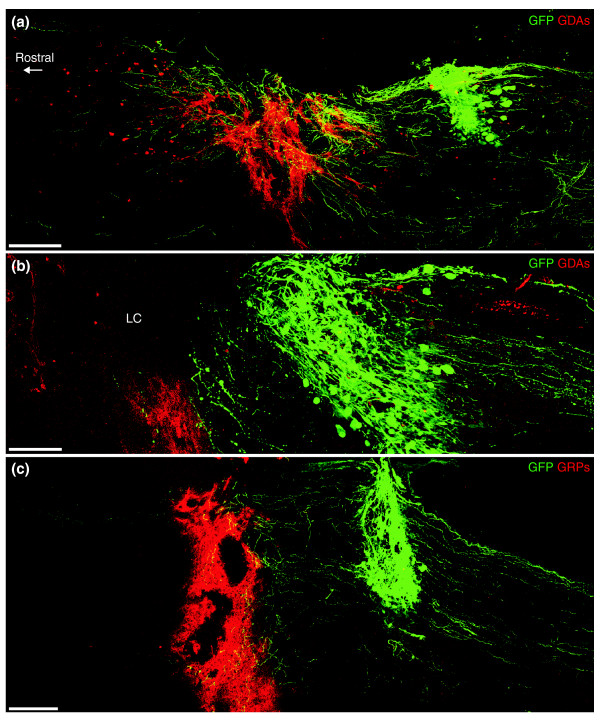
A comparison of the ability of GDA versus GRP transplants to promote axon growth across dorsal column injuries from adjacent microtransplanted adult sensory neurons at 8 days after injury and transplantation. (a) A montaged, confocal image scanned from a single 75-μm thick sagittally oriented section showing GFP+ axons (green) entering and exiting a dorsal column lesion bridged with hPAP+(red) GDAs. (b) In two cases in which GDA transplants did not adequately fill the injury site or migrate into lesion margins, GFP+sensory axons failed to cross the caudal lesion margin and instead formed dystrophic endings identical to those in control untreated injuries. LC, lesion center. (c) Confocal montage showing the complete failure of transplanted GRPs to support the growth of GFP axons across a dorsal column injury. Note that, despite the ability of transplanted GRPs to span the injury site, the majority of GFP+ axons have formed dystrophic endings within the caudal lesion margin. Scale bars: (a) 300 μm; (b) 100 μm; (c) 200 μm.